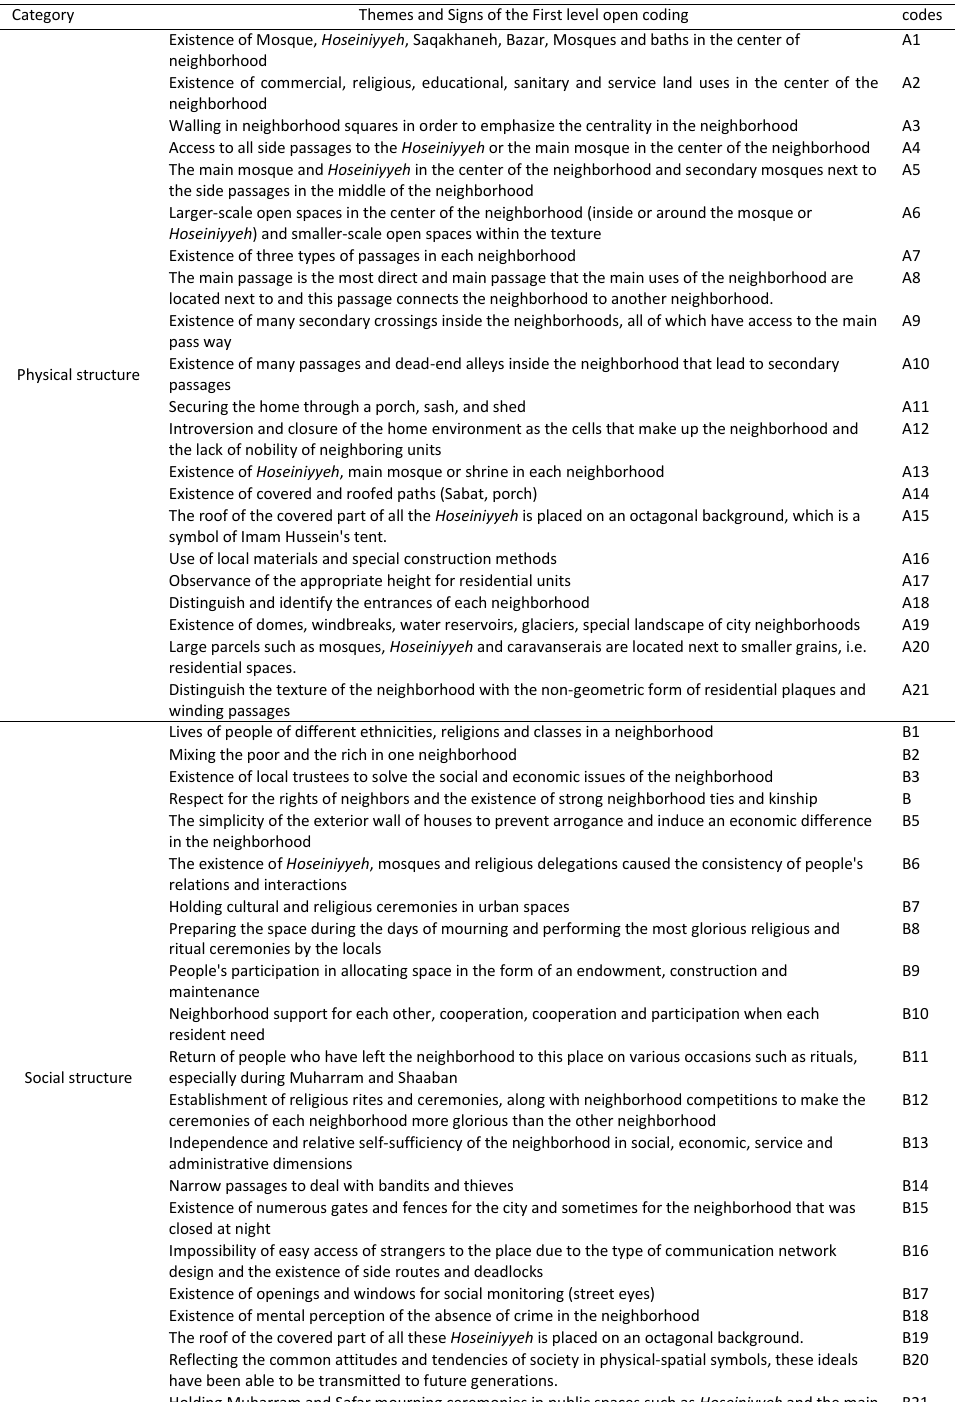
Table 1: contents analysis of neighborhood design principles in desert cities of